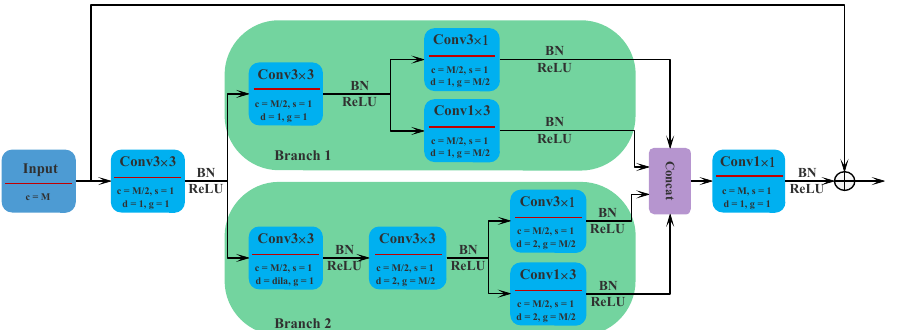
Figure 1. EDB module. (BN: Batch normalization; ReLU: Activation function, rectified linear unit; c: Channel number; colorblueM: A positive number divisible by 2; s: Convolution stride; d: Dilation rate; g: Group number).